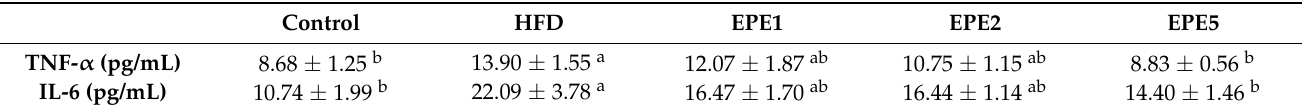
Data are shown as the mean ± S.E.M. ( n = 5). The values with different superscript letters (a,b) are significantly different ( p < 0.05), as determined via one-way ANOVA, and were analyzed by Duncan’s multiple range test.